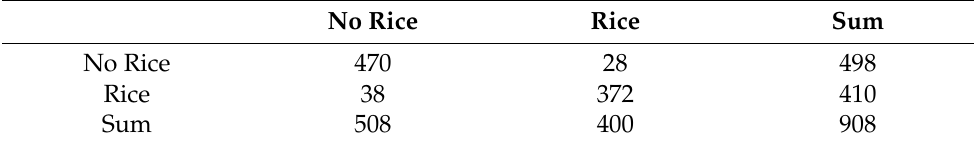
Table 11. Confusion matrix for time-series dates between May and September.